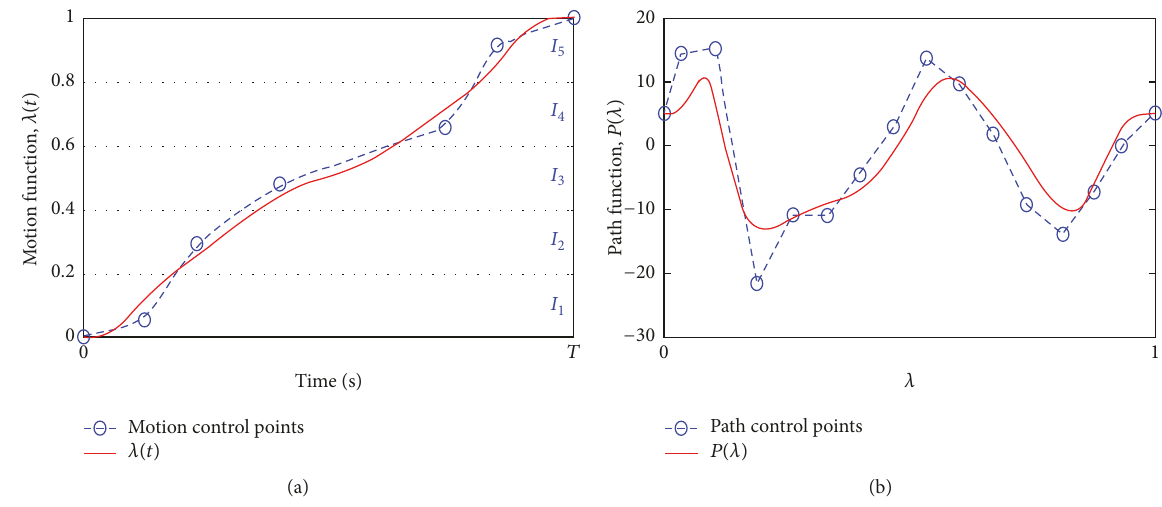
Figure 1: An illustration example for (a) motion 𝜆(𝑡) and (b) path 𝑃(𝜆) functions,